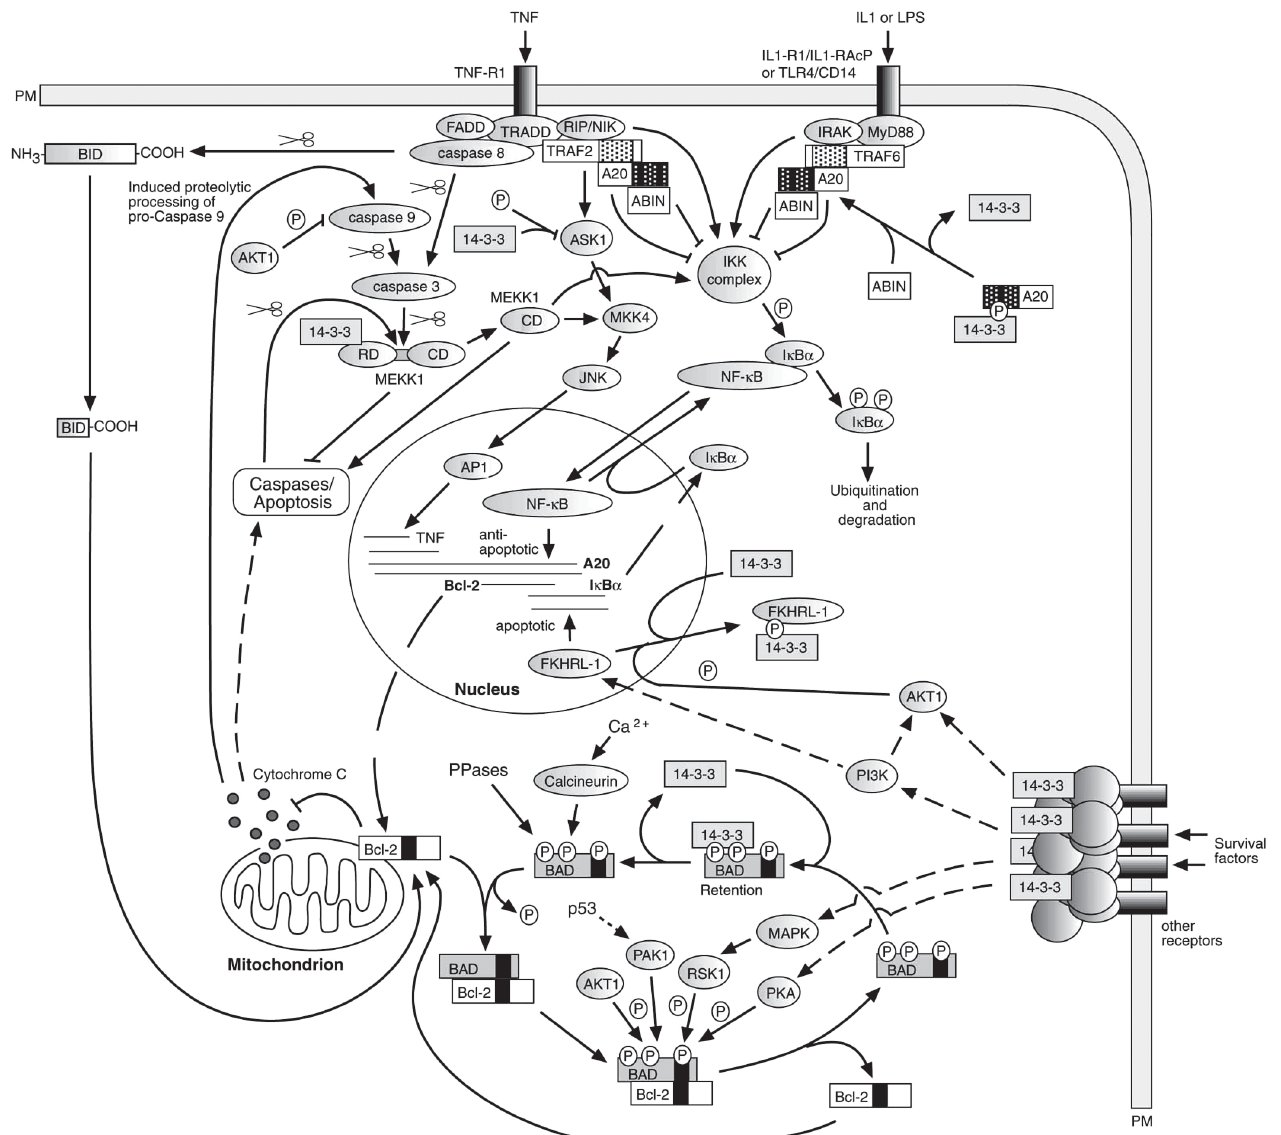
Figure 1. The complex apoptotic machinery. To date, five known 14-3-3 target proteins have been identified in the different pathways. Phosphorylation events are indicated by circled P, and proteolytic processing is indicated by